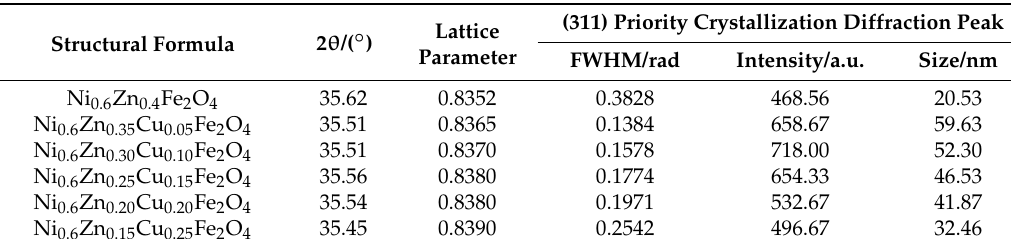
Figure 9. X-ray diffraction graph patterns of samples prepared with different Cu 2+ content ( a ) and without Cu 2+ content ( b ). Table 3. Composition and structure parameters of ferrite.